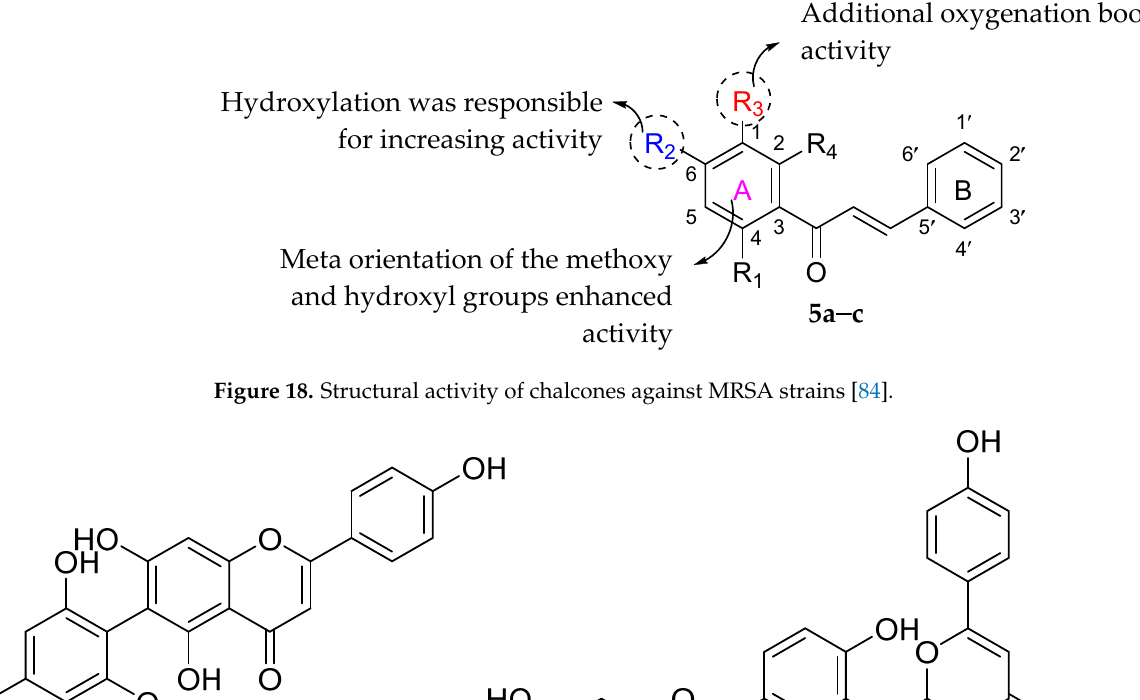
were shown to affect the antibacterial activity of the biflavonoids studied [85].